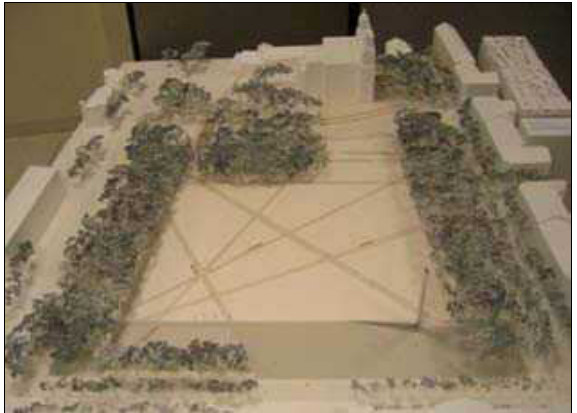
Fig. 8. Lukiškės Square reconstruction